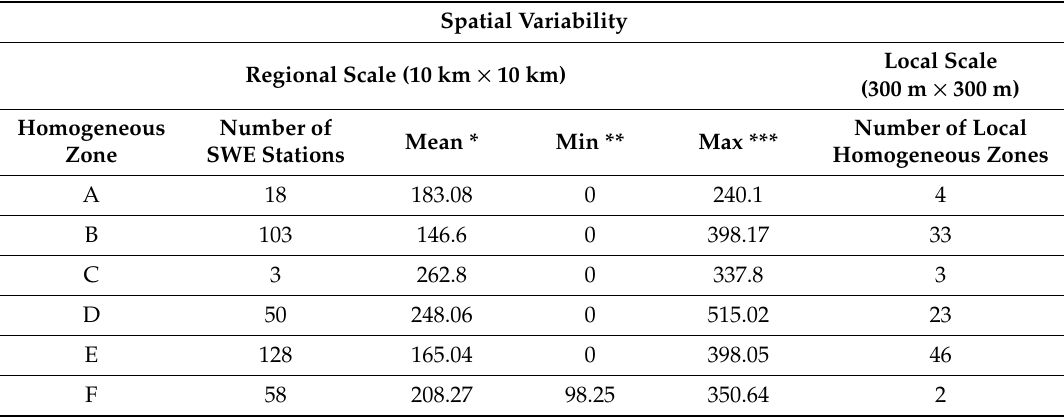
Table 1. Homogeneous zones at the regional and local scale and SWE statistical